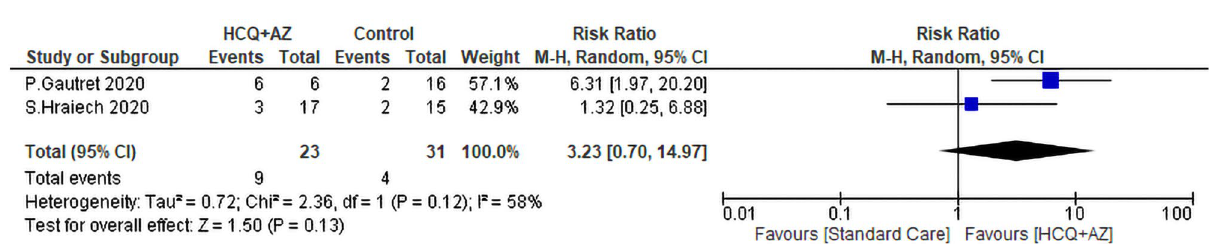
Figure 7. Forest plot for pooling risk ratios regarding the overall virological cure rate.